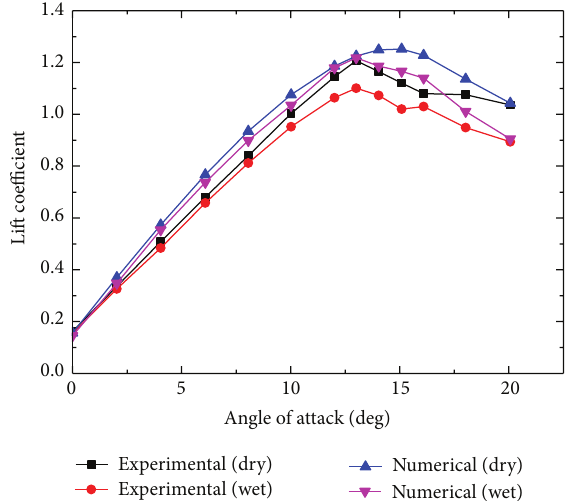
Figure 6: Lift coefficient versus AOA for numerical and experimen- tal results.